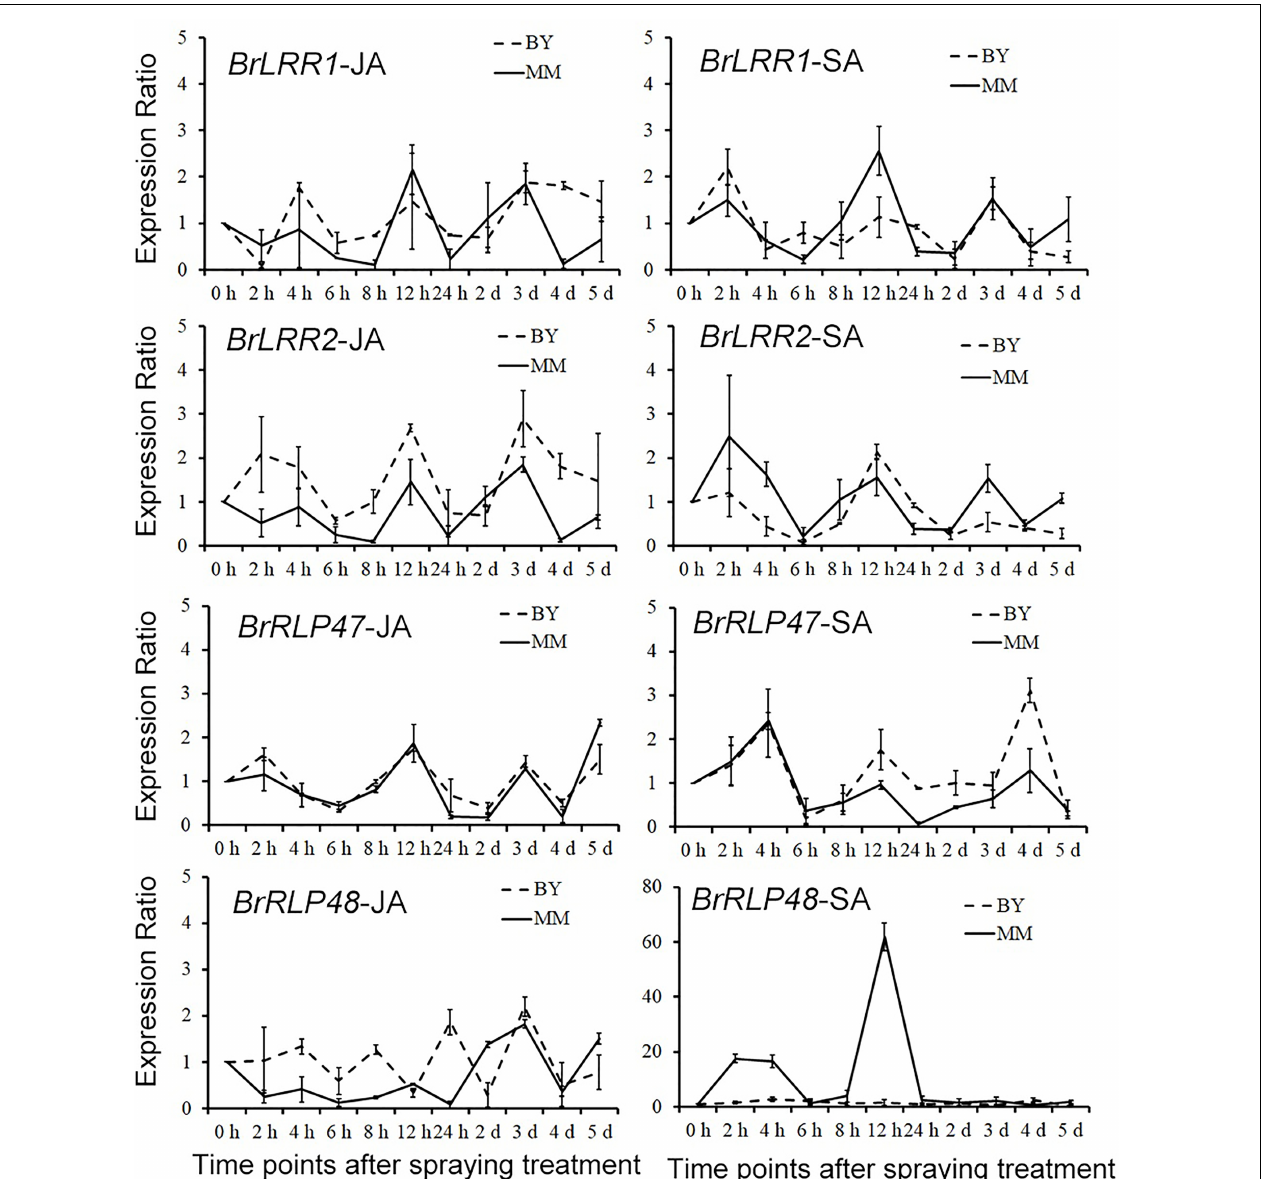
FIGURE 6 | Expression analysis of candidate genes under SA and JA treatments. The numbers in Y -axis denote the ratios of expression levels under SA and JA treatments compared to the controls. Five to eight leaves were pooled in a single sample in each replicate. Expression of each gene at 0 h after SA or JA treatment in BY or MM was defined as 1.0. Values represent means ± SD ( n = 3) from three biological replicates.